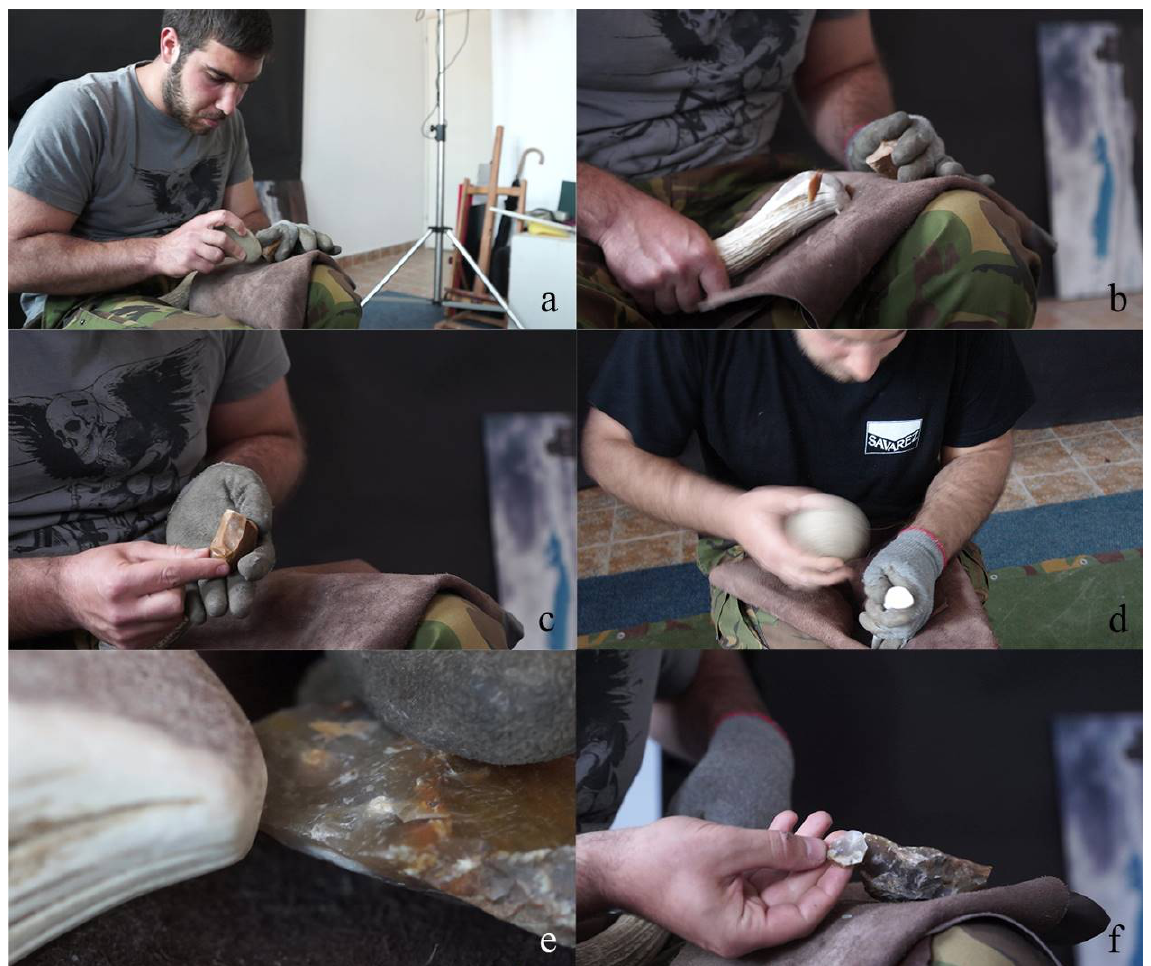
Figure 8. Exercises: hard hammer percussion and soft-hammer percussion as a corrective in future analysis of chipped stone